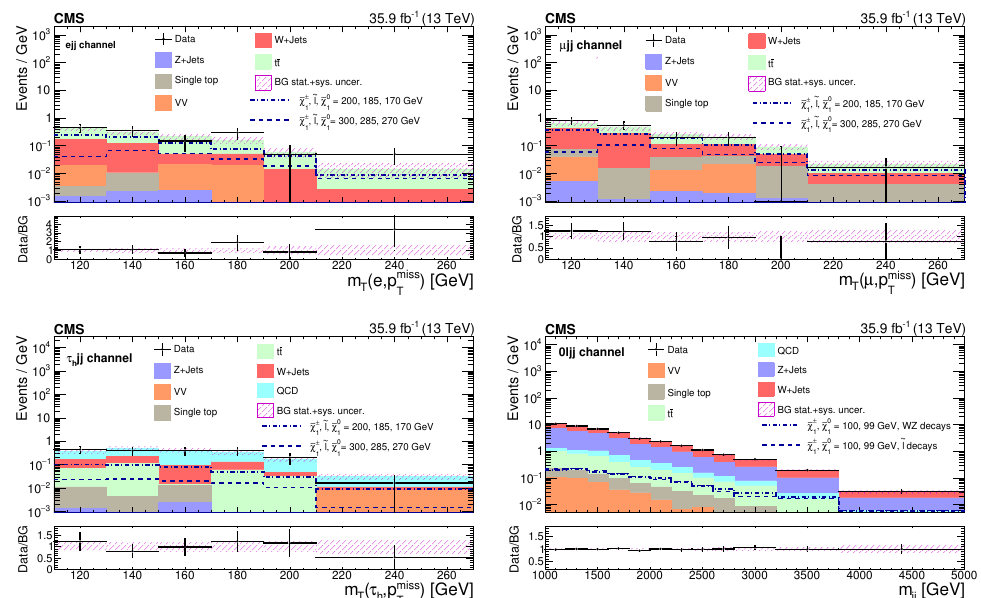
Figure 3 . The observed m and m distributions in the ejj (upper left), (cid:22) jj (upper right), (cid:28) T jj (lower left), and 0 ‘ jj (lower right) signal regions compared with the post-(cid:12)t SM background yields from the (cid:12)t described in the text. The pre-(cid:12)t background yields and shapes are determined using data-driven methods for the major backgrounds, and based on simulation for the smaller back- grounds. Expected signal distributions are overlaid. The last bin in the m 1 ‘ jj channels include all events with m > 210 GeV. The last bin of the m T 0 ‘ jj channel include all events with m > 3800 jj